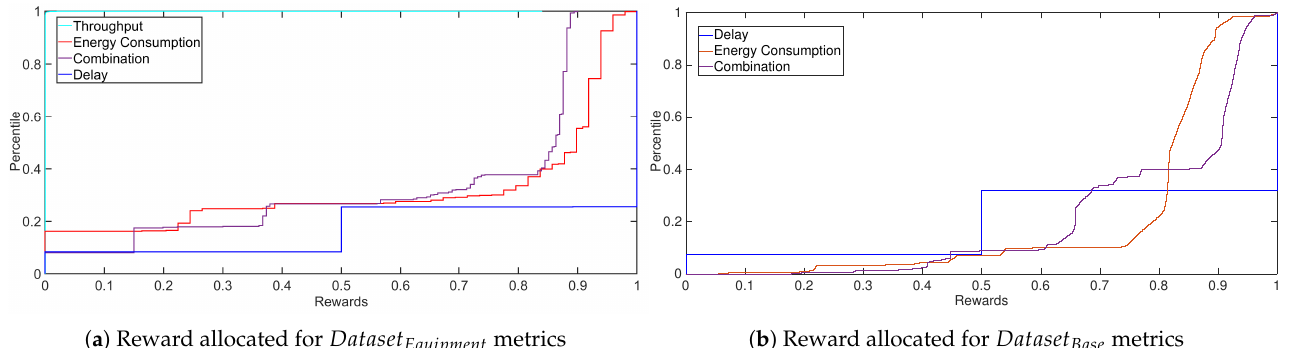
Figure 4. ECDF of reward for single and combined performance metric suggestion for Dataset Base and Dataset Equipment utilising the most optimal RL with Gradient